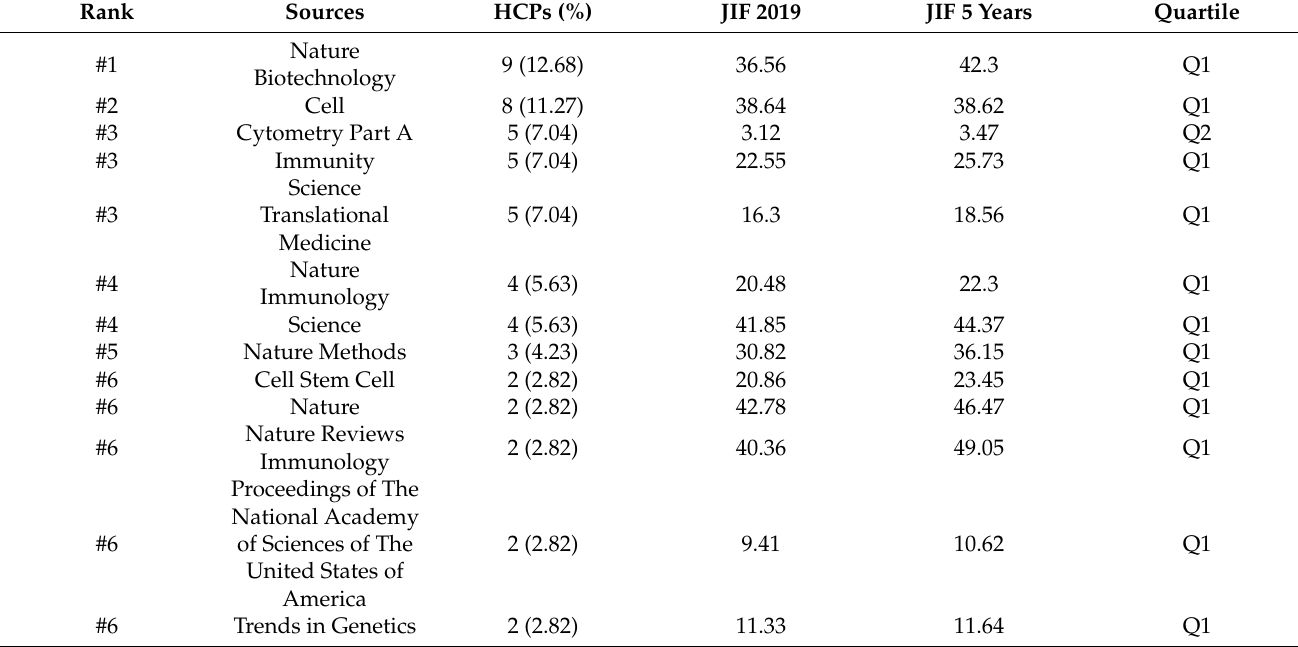
Table 2. Distribution of sources with two or more HCPs in the area of mass cytometry.